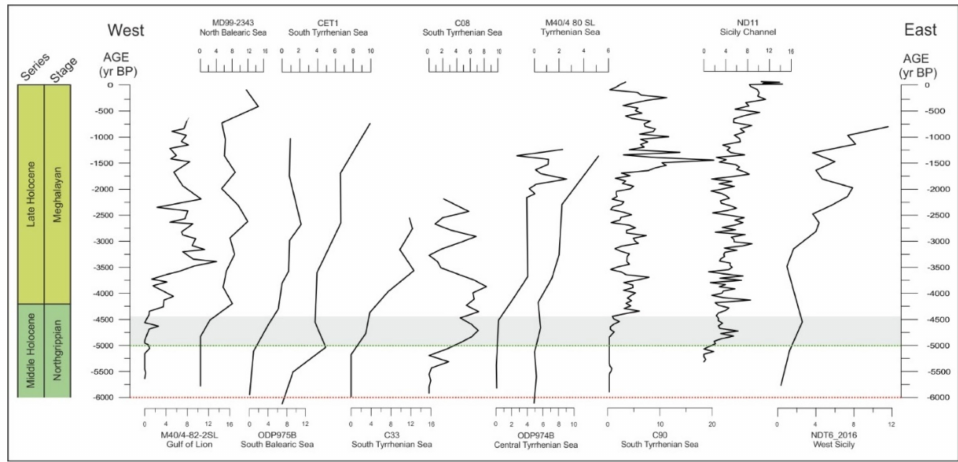
Figure 3. Chronological comparisons of G. truncatulinoides (left-coiled) abundance percentages (black line) between the marine records: M40/4-82-2SL [44, MD99-2343 [27], ODP975B [44], CET1 [45] (Morabito et al. 2014), C33 [94], C08 [47], ODP 974B [44], M40/4 80 SL [44], C5 [5], C90 [29], ND11 [30], and NDT6_2016 [10]. The gray bar represents the phase in which G. truncatulinoides begins to increase in percentage. The red dashed line corresponds to the end of the Sapropel S1 and the green dashed line corresponds to the end of the African Humid